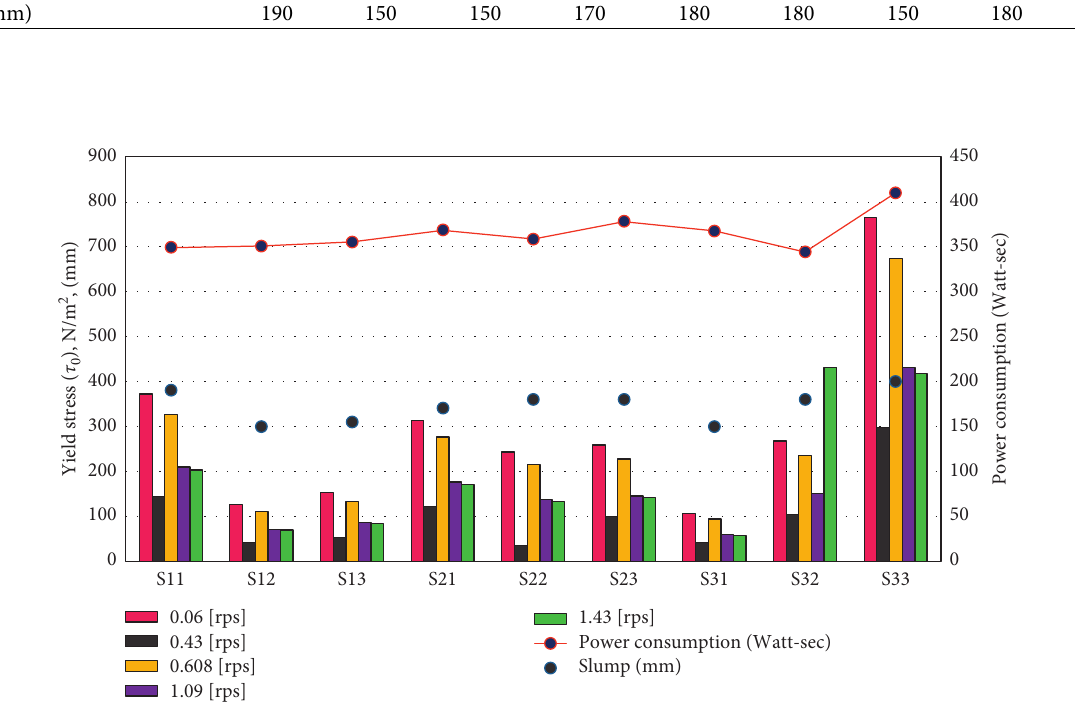
Figure 18: Yield stress for the different mix for various rev/sec and corresponding slump value versus power